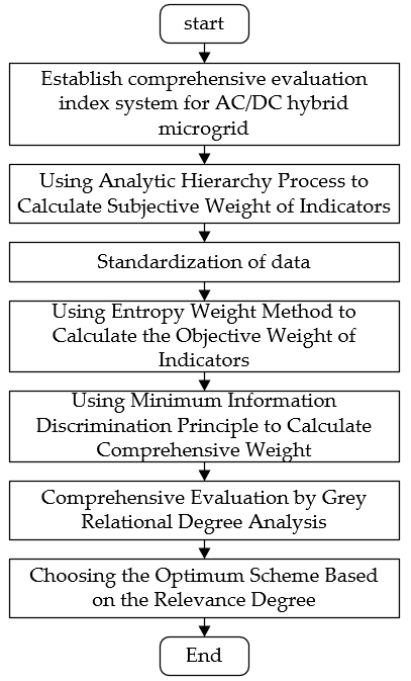
Figure 2. Comprehensive evaluation flow of AC / DC hybrid microgrid planning based on analytic hierarchy process and entropy weight method.